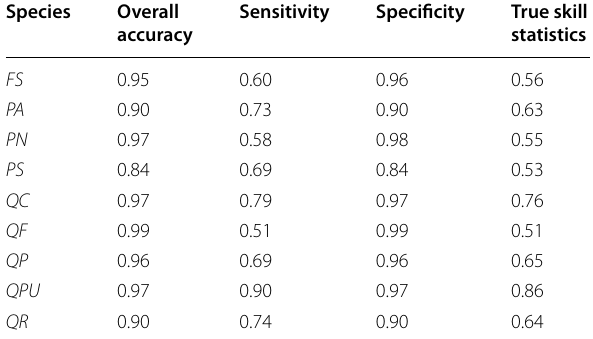
Table 3 Accuracy of the model for the investigated tree species